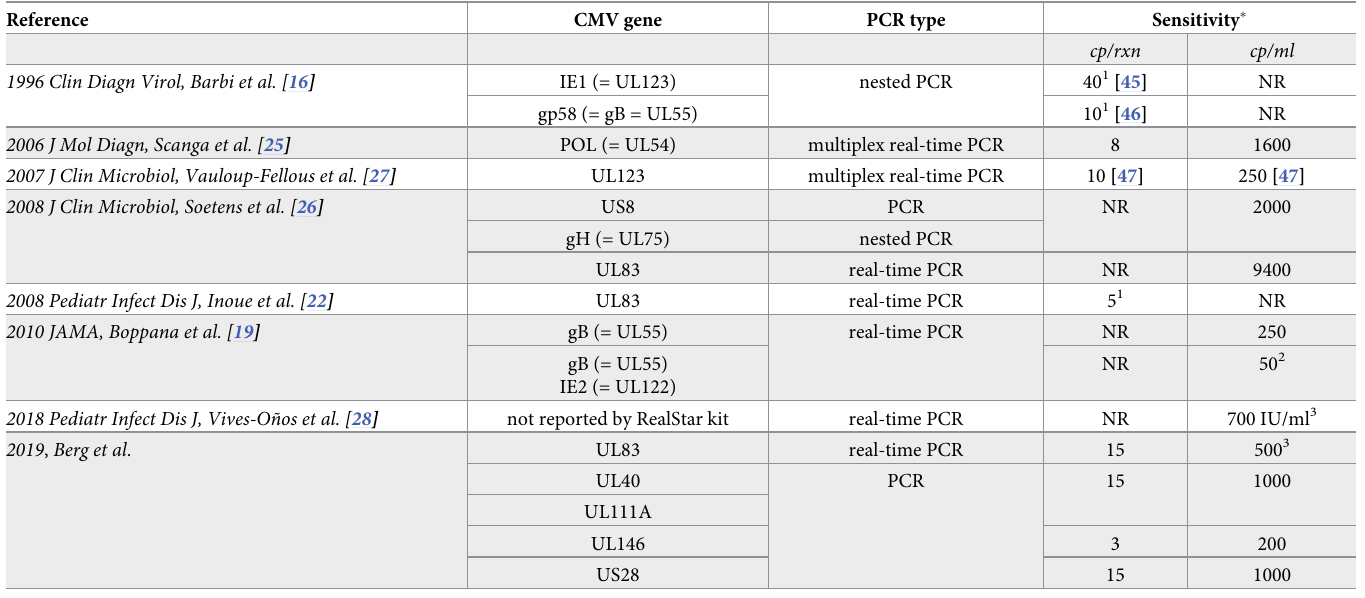
NR = Not reported in study. Rxn = Reaction. � The sensitivities of the two commercial kits (R-gene and RealStar) as well as reference 27 is reported as LLOD, whereas as all other references report the lowest consistently positive CMV concentration.